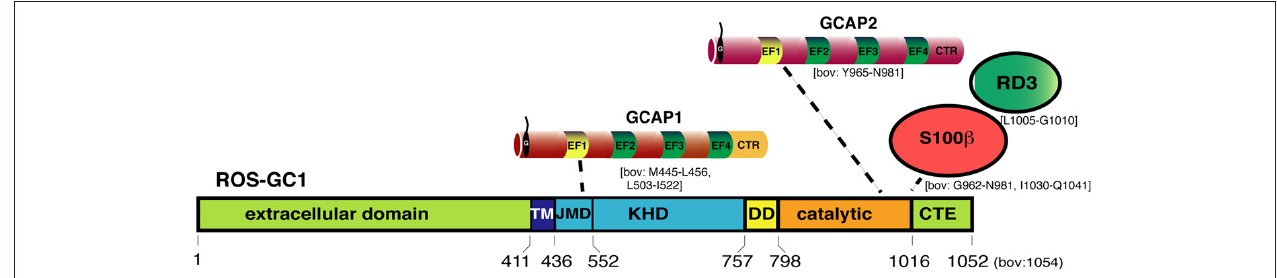
FIGURE 4 | Schematic representation of ROS-GC1 and ROS-GC1-interaction partners in photoreceptors. ROS-GC1 contains an aminoterminal extracellular domain, transmembrane domain (TM), kinase homology domain (KHD), dimerization domain (DD), and the catalytic domain that converts GTP into cGMP. The aminoterminal portion of the KHD is also referred to as juxtamembrane domain (JMD) [Lange et al. (1999)]. The borders of the respective domains are schematically depicted in the amino acid sequence of human ROS-GC1 (NP_000171, GI: 4504217). Numbers indicated correspond to the mature ROS-GC1 protein (without leader sequence). The borders of the individual domains were determined by the analyses of various ROS-GC1 constructs; the precise structure of photoreceptor ROS-GC1 (e.g., X-ray-structure) is not yet available. At the intracellular domains of ROS-GC1, different NCS proteins bind at different locations. GCAP1 binds to the JMD, the aminoterminal portion of the kinase homology domain of ROS-GC1 probably via its aminoterminal EF1 hand. In contrast, S100 β and GCAP2 bind close to each other to the catalytic domain. The binding of GCAPs appears to compete with the binding of the retinal degeneration protein 3 (RD3). While GCAPs inhibit